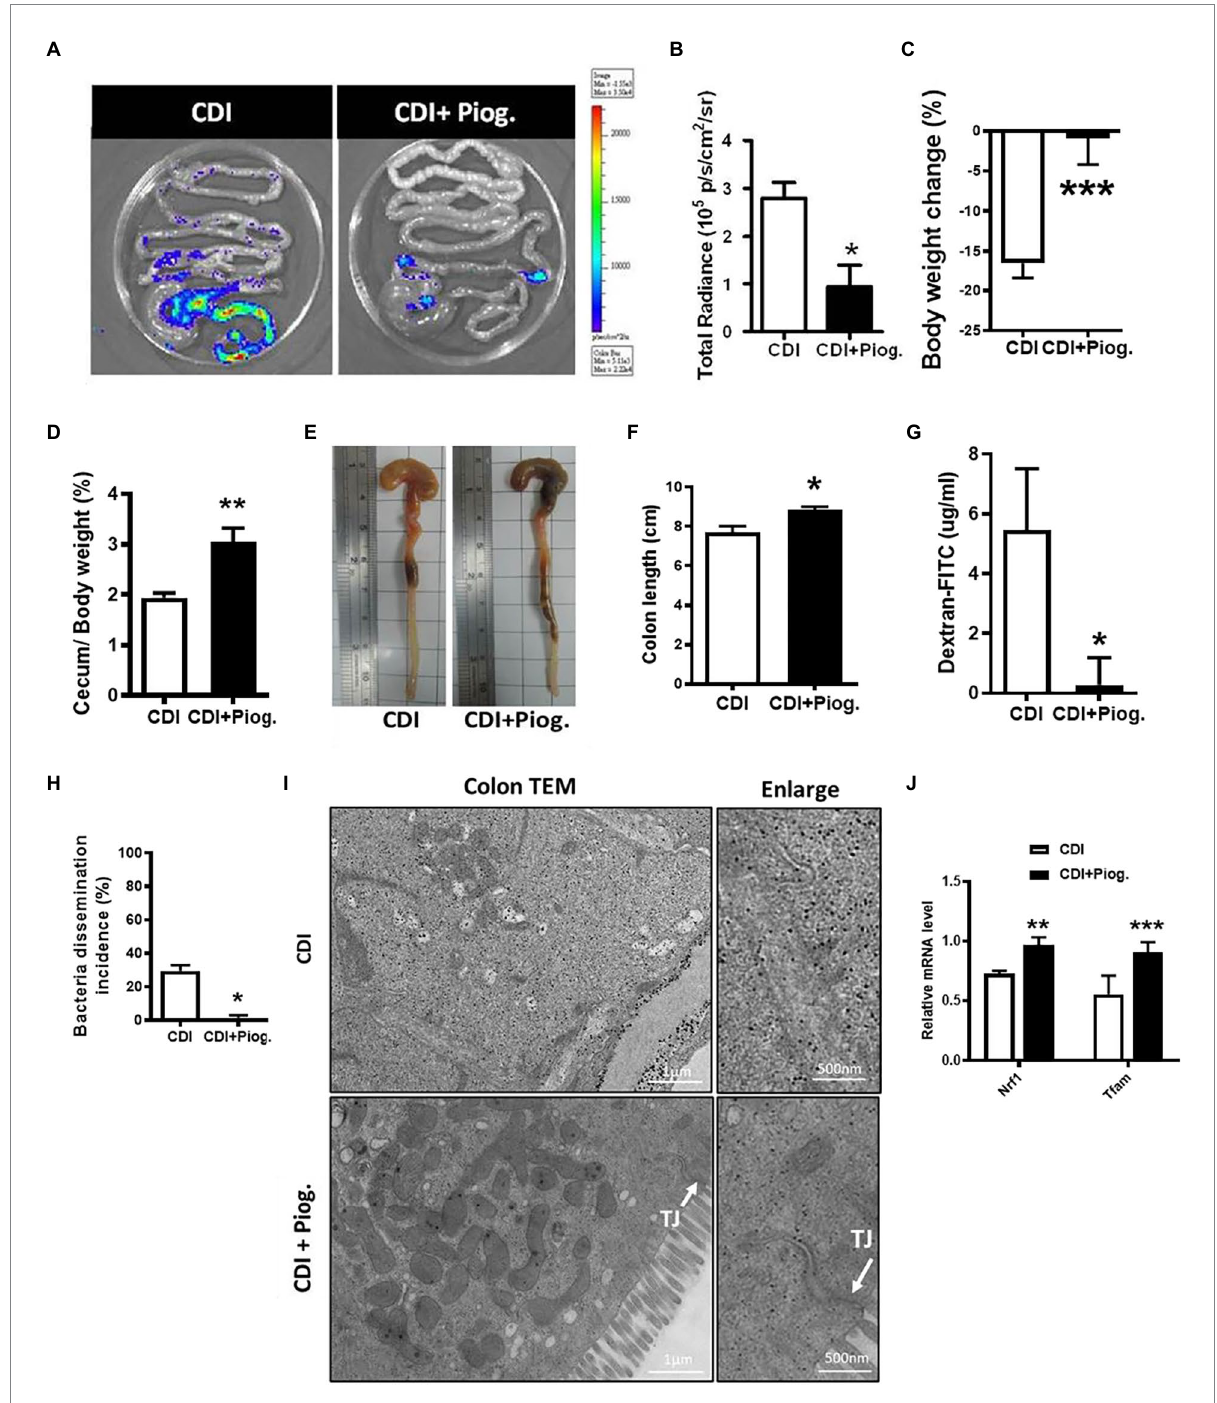
FIGURE 6 Pioglitazone attenuated C. difficile -induced inflammation and barrier dysfunction in NF- κ B-RE-Luc reporter mice. NF- κ B-RE-Luc reporter mice were either left untreated or treated with pioglitazone orally for 5 days and then challenged with C. difficile for 48 h. (A) Activation of NF- κ B in the cecum and colon was monitored by using in vivo bioluminescence imaging. (B) Quantification of luminescence levels in the gut from CDI mice with or without pioglitazone treatment. (C–F) Change in body weight, change of cecum weight divided by body weight, gross view of cecum and colon, and colon length were assessed 2 days after infection. (G) Translocation of dextran-FITC from CDI mice with or without pioglitazone treatment. (H) Percentage of bacterial dissemination to other organs in mice with or without pioglitazone. (I) Transmission electron micrograph of colon tissues from CDI mice with or without administration of pioglitazone. White arrows indicate the position of the tight junction on the microscopic images of CDI with pioglitazone treatment. Scale bars stand for 1 μ m and 500 nm. (J) PPAR- γ activation triggered by pioglitazone was monitored by PPAR- γ downstream genes. RT-qPCR analysis of the expression of indicated genes in colon tissue of C. difficile infection with or without pioglitazone treatment on day 2 after infection. Values are expressed as mean ± SEM (*, p < 0.05; **, p < 0.01; ***, p < 0.001 relative to control group). All data are representative of five independent